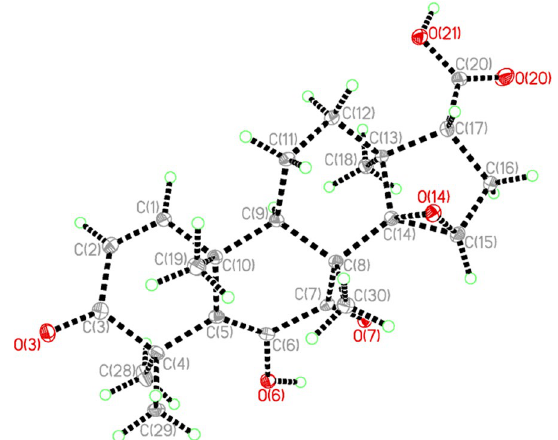
Fig. 4 Single‑crystal X‑ray structure of 6